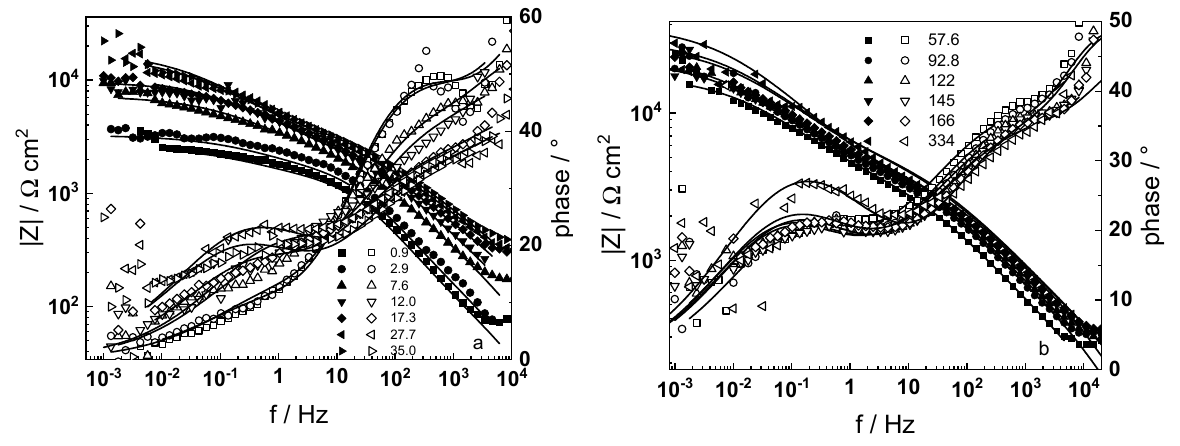
Figure 5. Electrochemical impedance spectra of in-situ pre-hydrogenated sample (potentiostatic